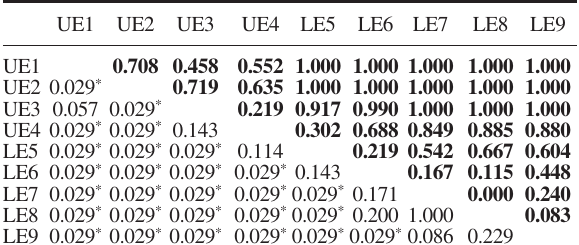
Fig . 2. – Two dimensional MDS plots based on Bray-Curtis similar- ities of fourth-root transformed macroinvertebrate abundance data: (a) ordination using inter-species resemblance matrix of nine sta- tions; (b) ordination of the nine stations sampled in the Ebro estuary. The dashed line and the solid line encircle the freshwater and marine communities respectively. See Figure 1 for sampling station codes. Table 3. – One-way ANOSIM test to compare the macroinverte- brate communities at different sampling stations. The test results are shown in the lower diagonal of the table. Significant differences between stations ( P <0.05) are indicated (*). The R values are shown in bold letters in the upper diagonal of the table. See Figure 1 for sampling station